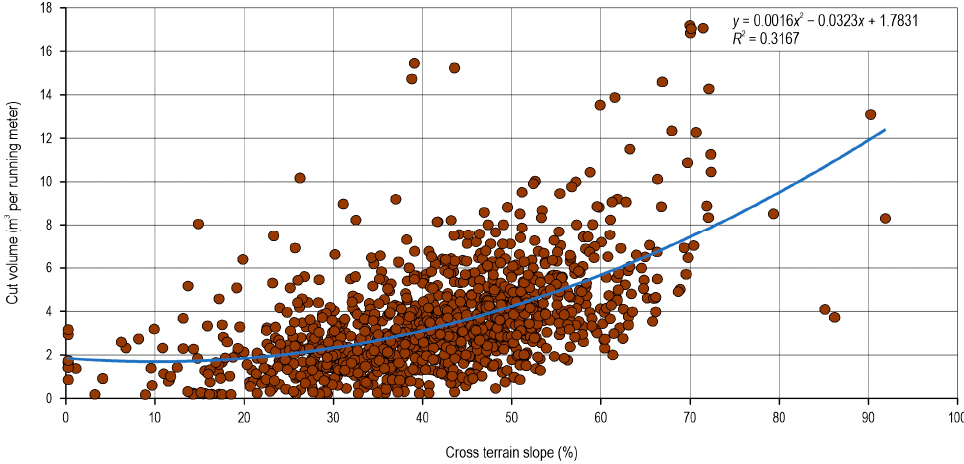
Figure 4. Impact of cross terrain slope on cut volume.